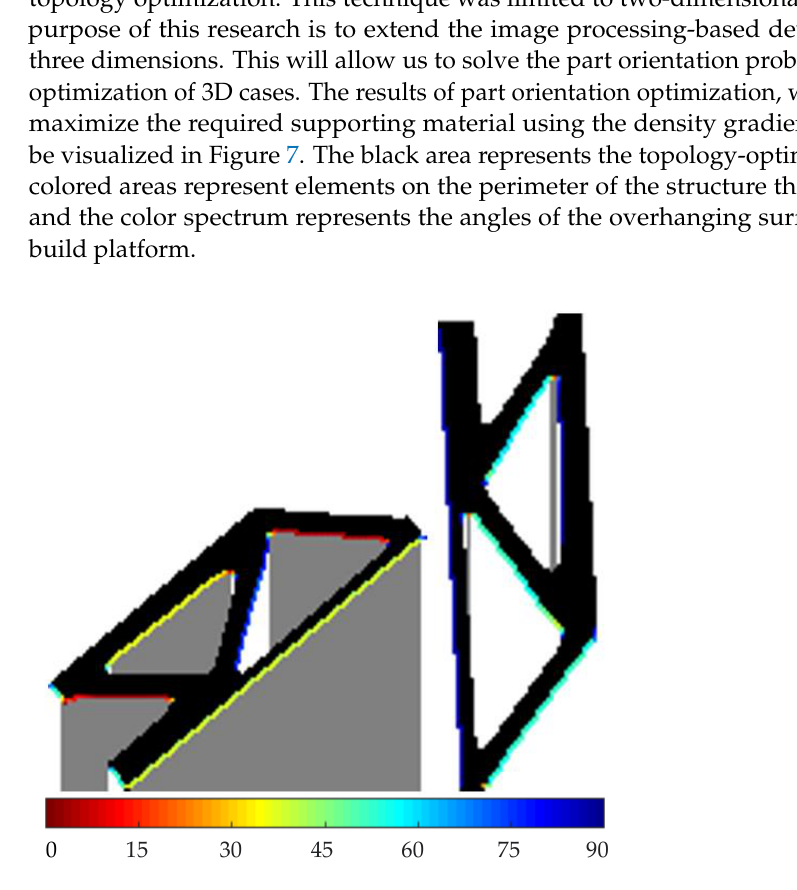
Figure 7. Print orientations that maximize ( left ) and minimize ( right ) the required volume of supporting structure [40].